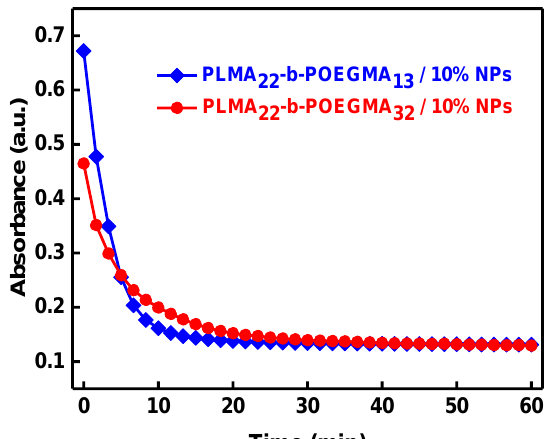
Figure 4. Magnetophoresis graphs measuring absorbance as a function of time (λ = 450 nm) for PLMA 22 - b -POEGMA 32 and PLMA 22 - b -POEGMA 58 micelles loaded with 10 wt % magnetic NPs in regard to PLMA mass in the mixed nanosystem.